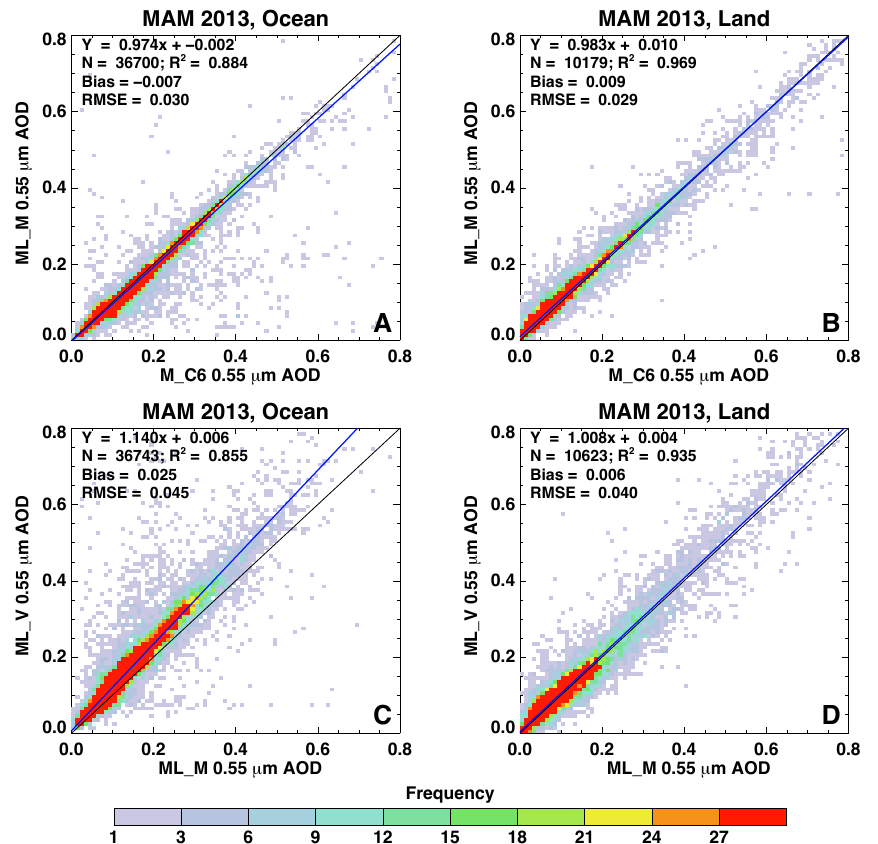
Figure 10. Comparison of mean AOD in collocated grids from the Spring 2013 maps (e.g., Fig. 7), for ocean retrievals ( a and c ) and land retrievals ( b and d ). The top panels ( a and b ) are MODIS-like on MODIS compared to the MODIS C6, and the bottom panels ( c and d ) are for ML_V vs. ML_M. Statistics (regression equation, number of collocated grids, correlation, bias and RMSE) are provided as text in each panel.